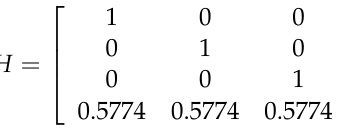
Figure 3. Residual vector values for Gyro 1–4 injection of 5 σ fault